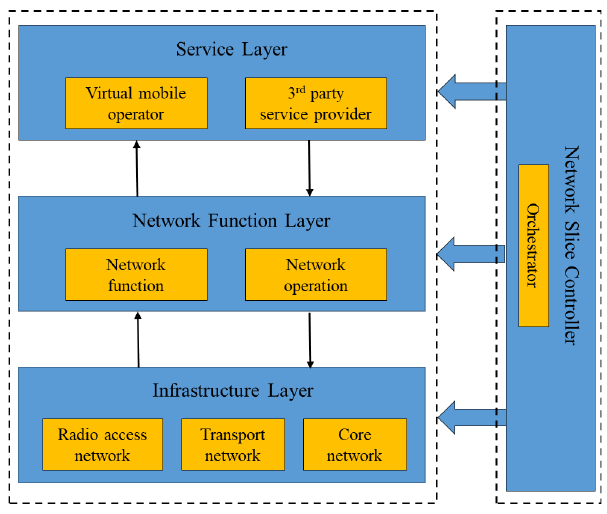
Figure 3. The 5G NS architecture.